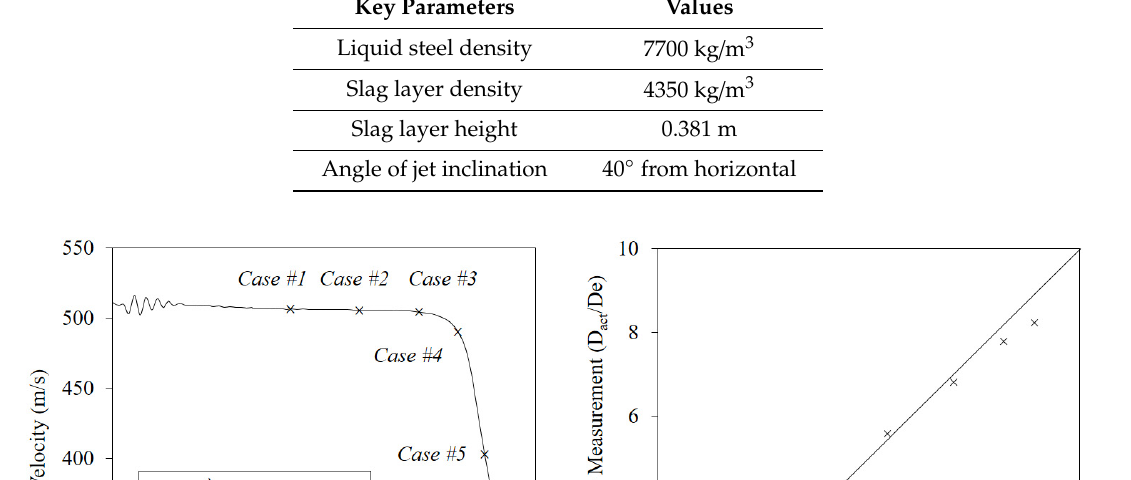
Table 2. Key parameters of bath for jet penetration cavity estimation.